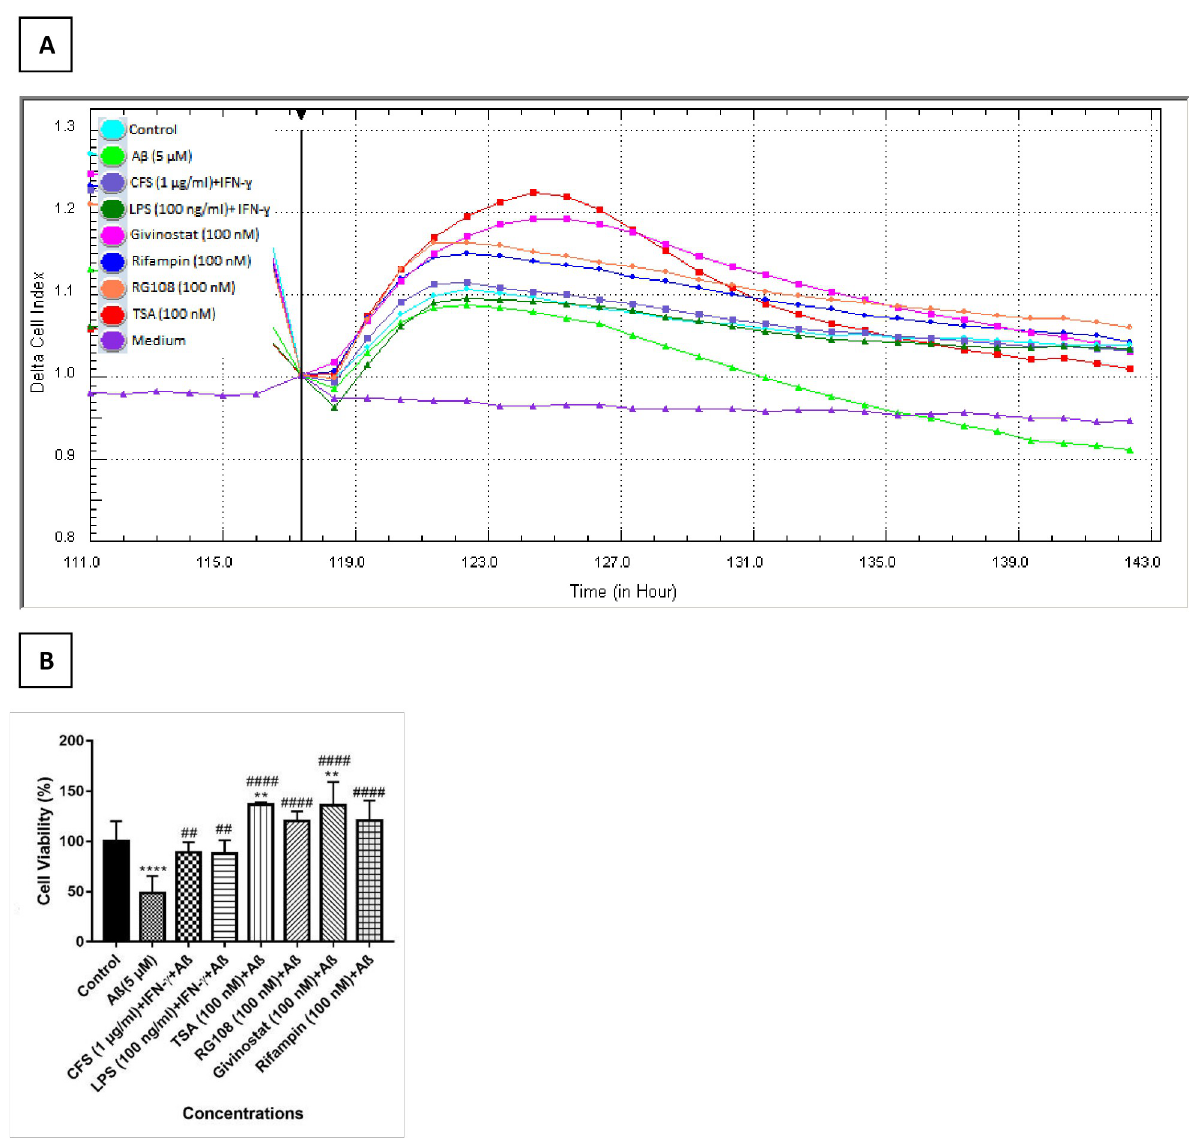
Fig 7. Effects of the treatment groups on differentiated SH-SY5Y cell viability in the presence of 5 μ m A β . (A) After 24 hours of incubation with treatment groups, real-time CI values were monitored to investigate the neuroprotective effects of the treatment groups against 5 μ m A β toxicity (n = 4). (B) The slope graph is drawn according to the average CI data at 0 th , 12 th and 24 th hours after A β application to SH-SY5Y cells for the neurotoxicity analysis. The results are presented as the mean ± SD of three different experiments, n = 4 for each treatment group, no difference: p > 0.05 ns; significant difference: �� p < 0.01 and ���� p < 0.0001 according to the control group; significant difference: ## p < 0.01 and #### p < 0.0001 according to the A β